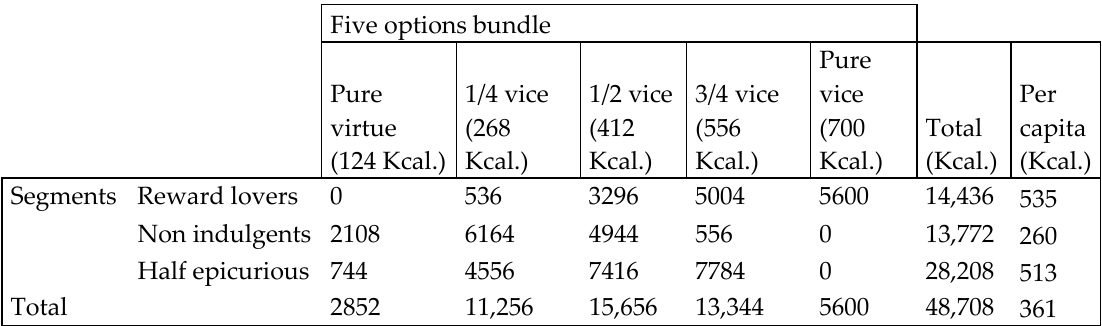
Table 4. Segment’s food choice. Pure virtue-pure vice set (calories).